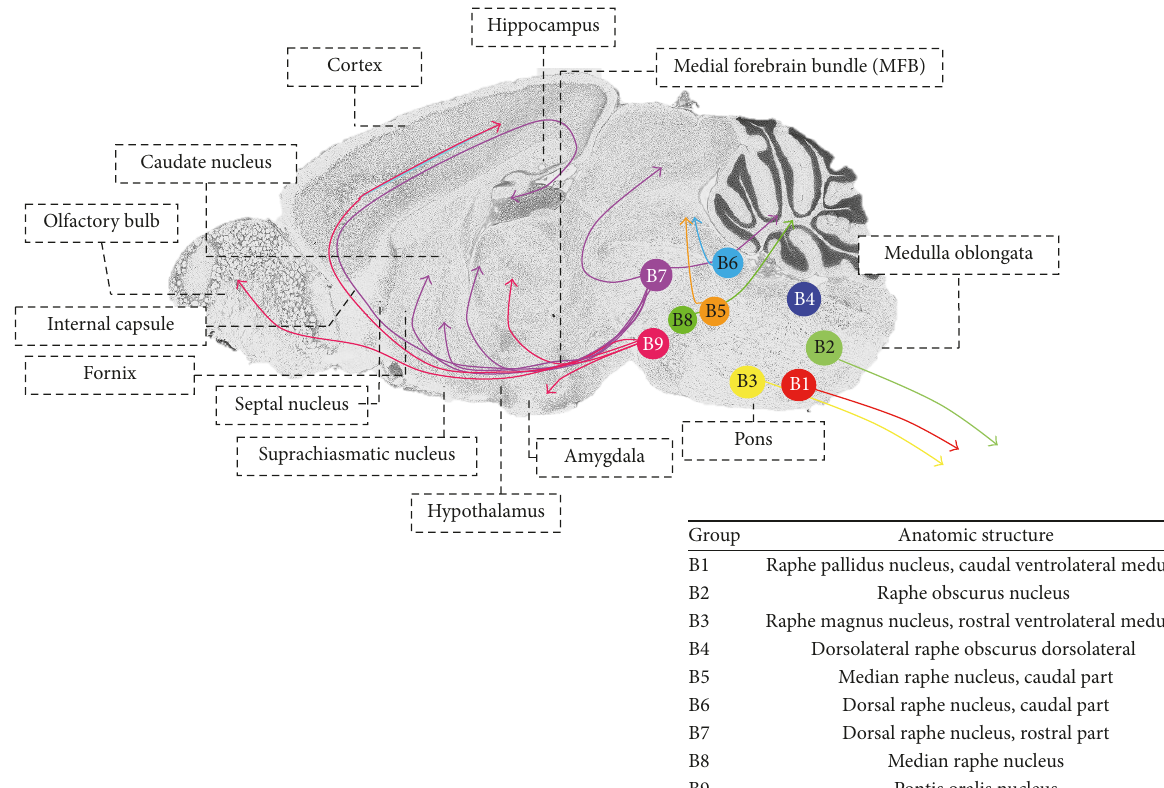
Figure 2: Location of serotonergic nuclei. Adapted from [12,